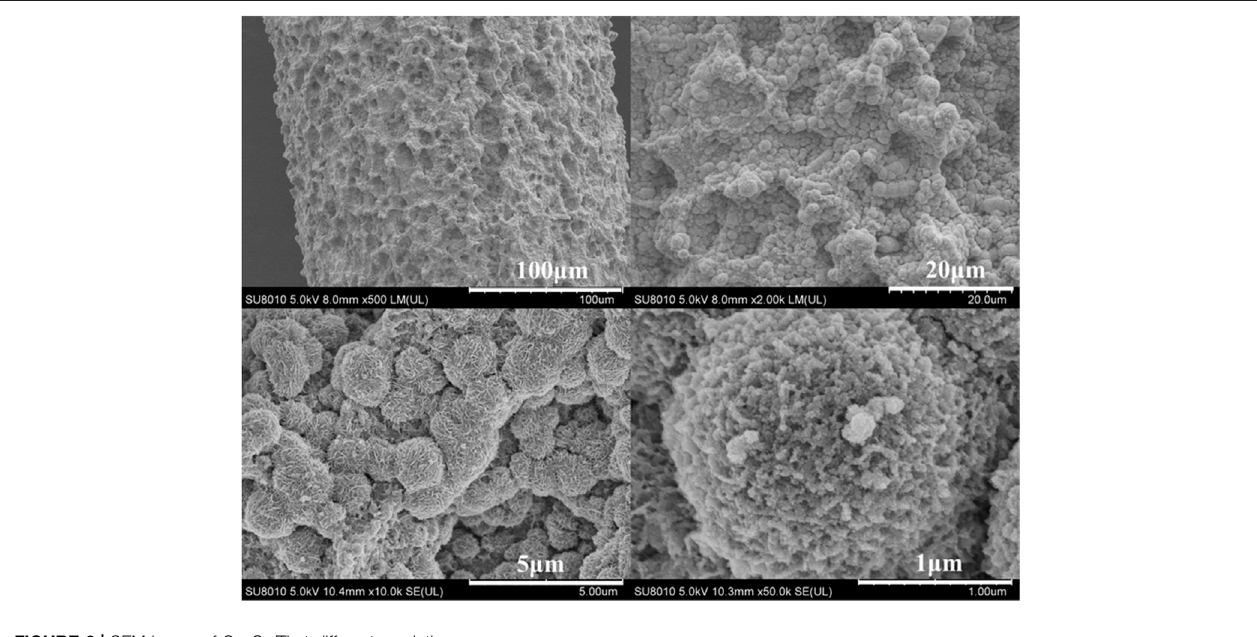
FIGURE 2 | SEM image of Co 3 O 4 /Ti at different resolutions.